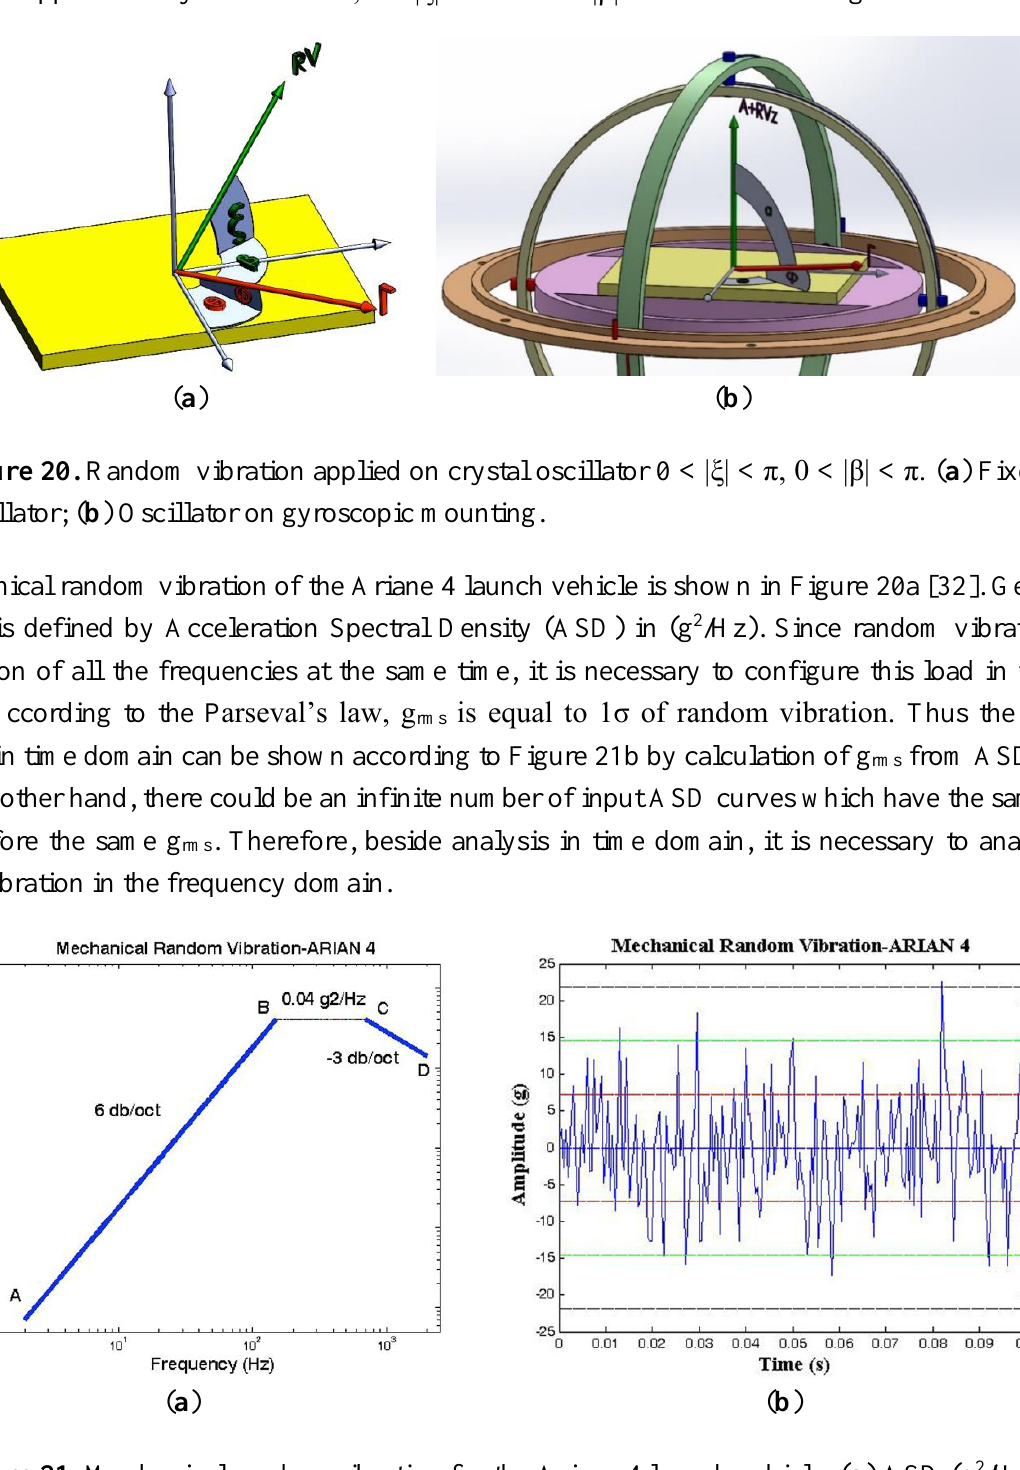
Figure 21. Mechanical random vibration for the Ariane 4 launch vehicle. ( a ) ASD (g 2 /Hz); Adapted from [32]. ( b ) Time domain